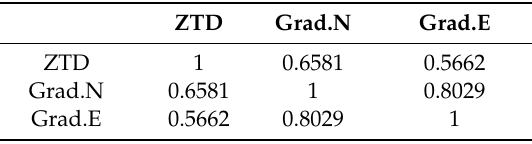
Table 1. Correlation coe ffi